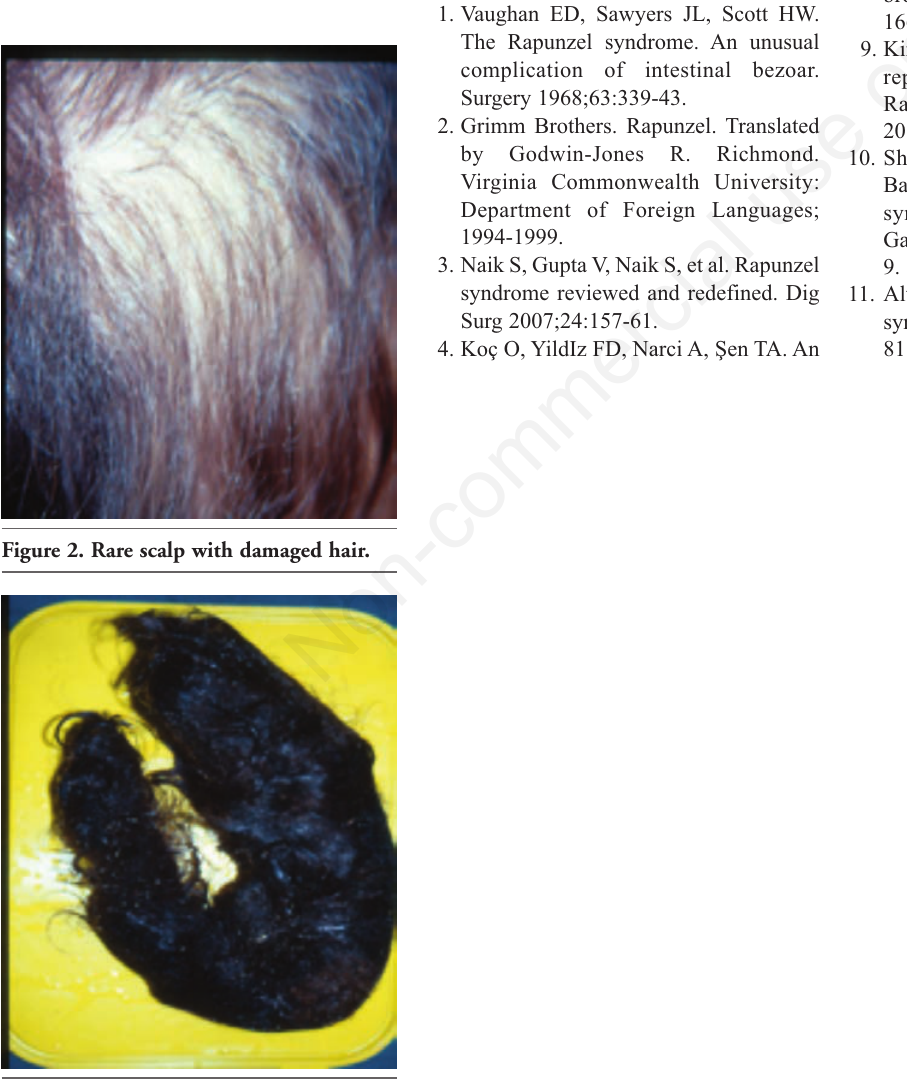
Figure 3. Trichobezoar: 38×12.5 weighing 1